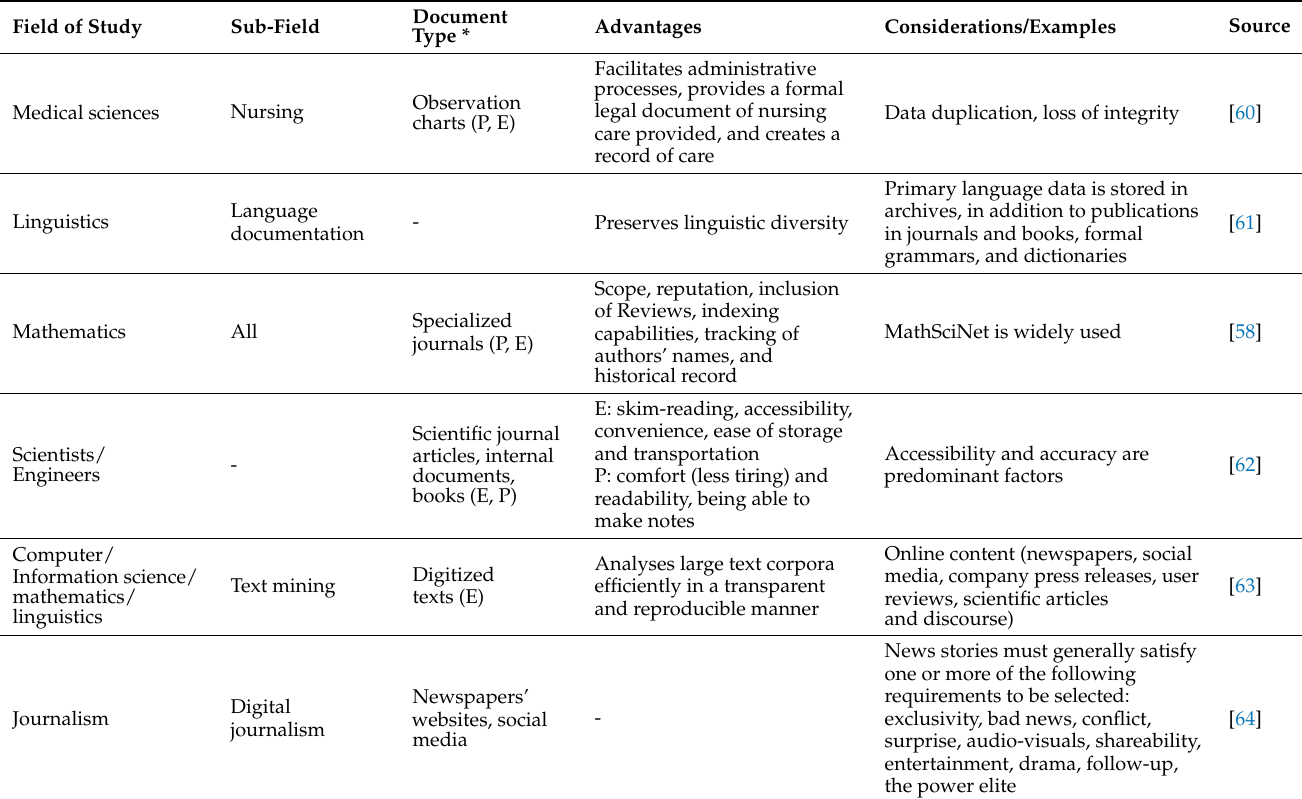
Table 3. Features of documentation used in selected fields of